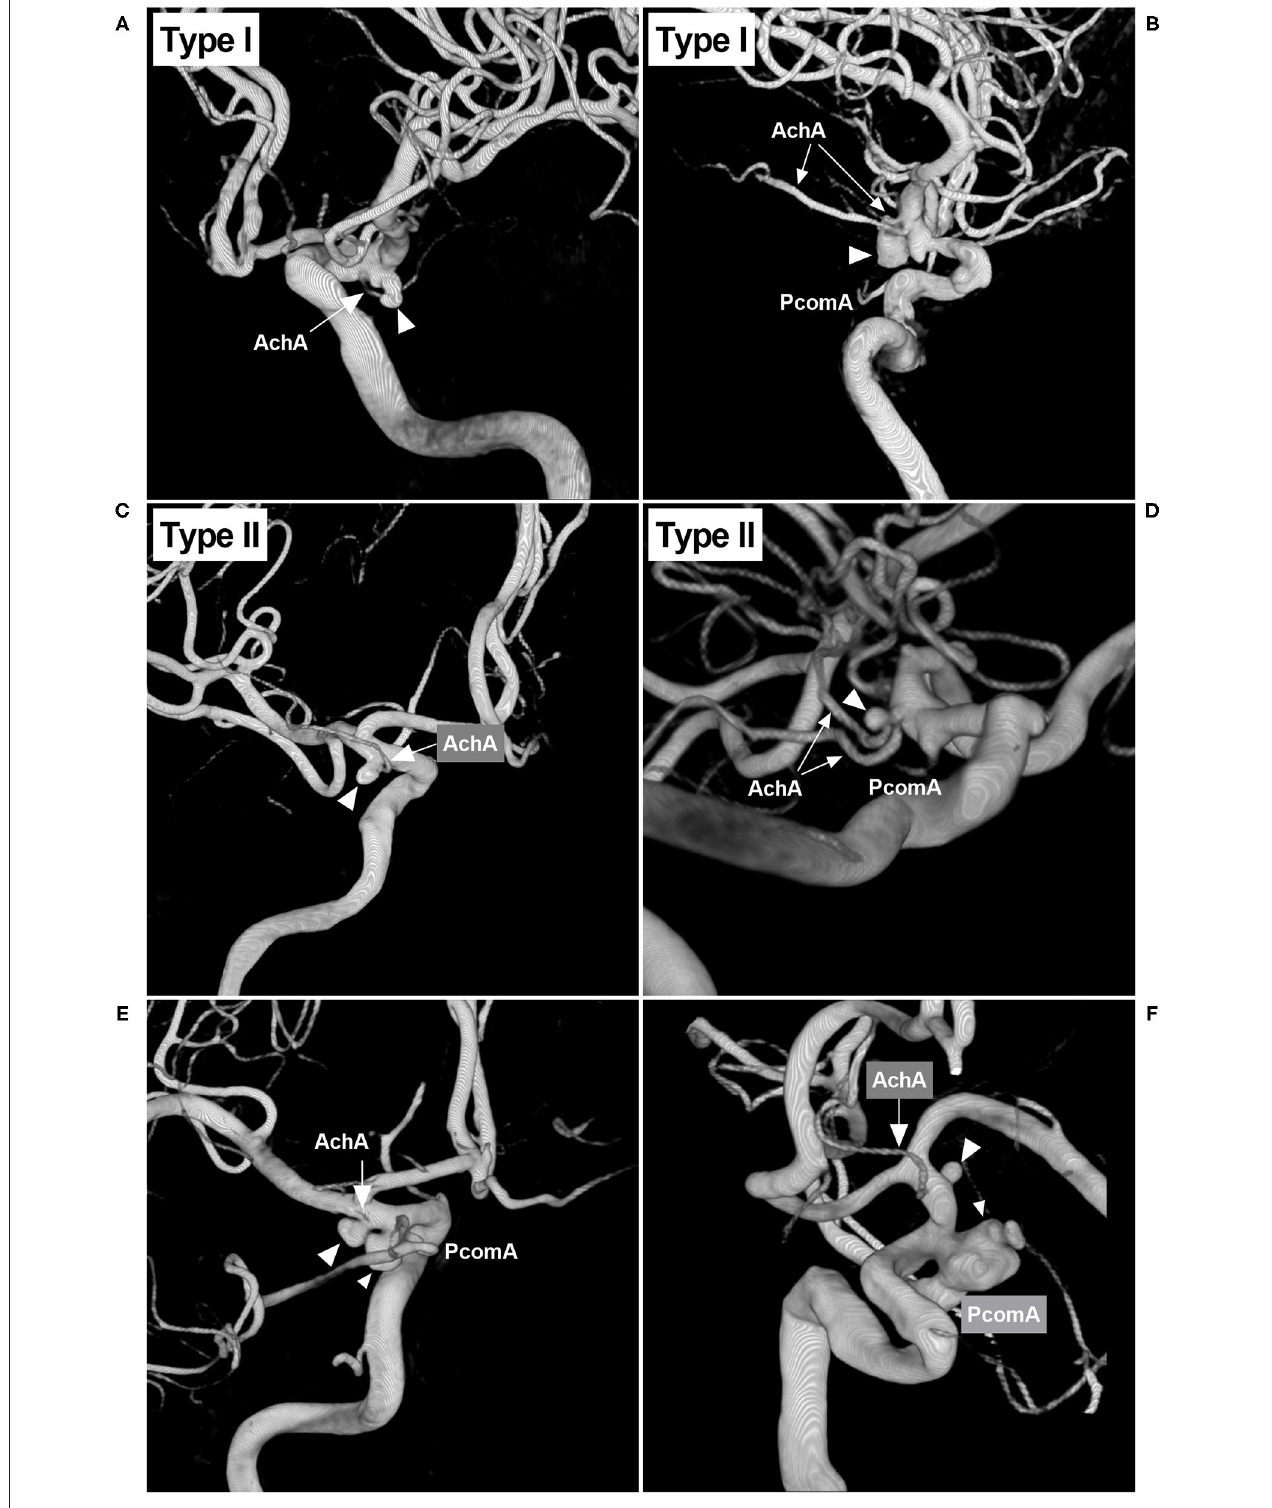
FIGURE 3 | Classifications of the AchA aneurysm and associated aneurysms. (A) 3D-DSA showing an AchA aneurysm (triangle): a single-trunk AchA (arrow) was located away from the aneurysm neck; this type of aneurysm belongs to type I. (B) 3D-DSA showing an AchA aneurysm (triangle): a duplicate AchA